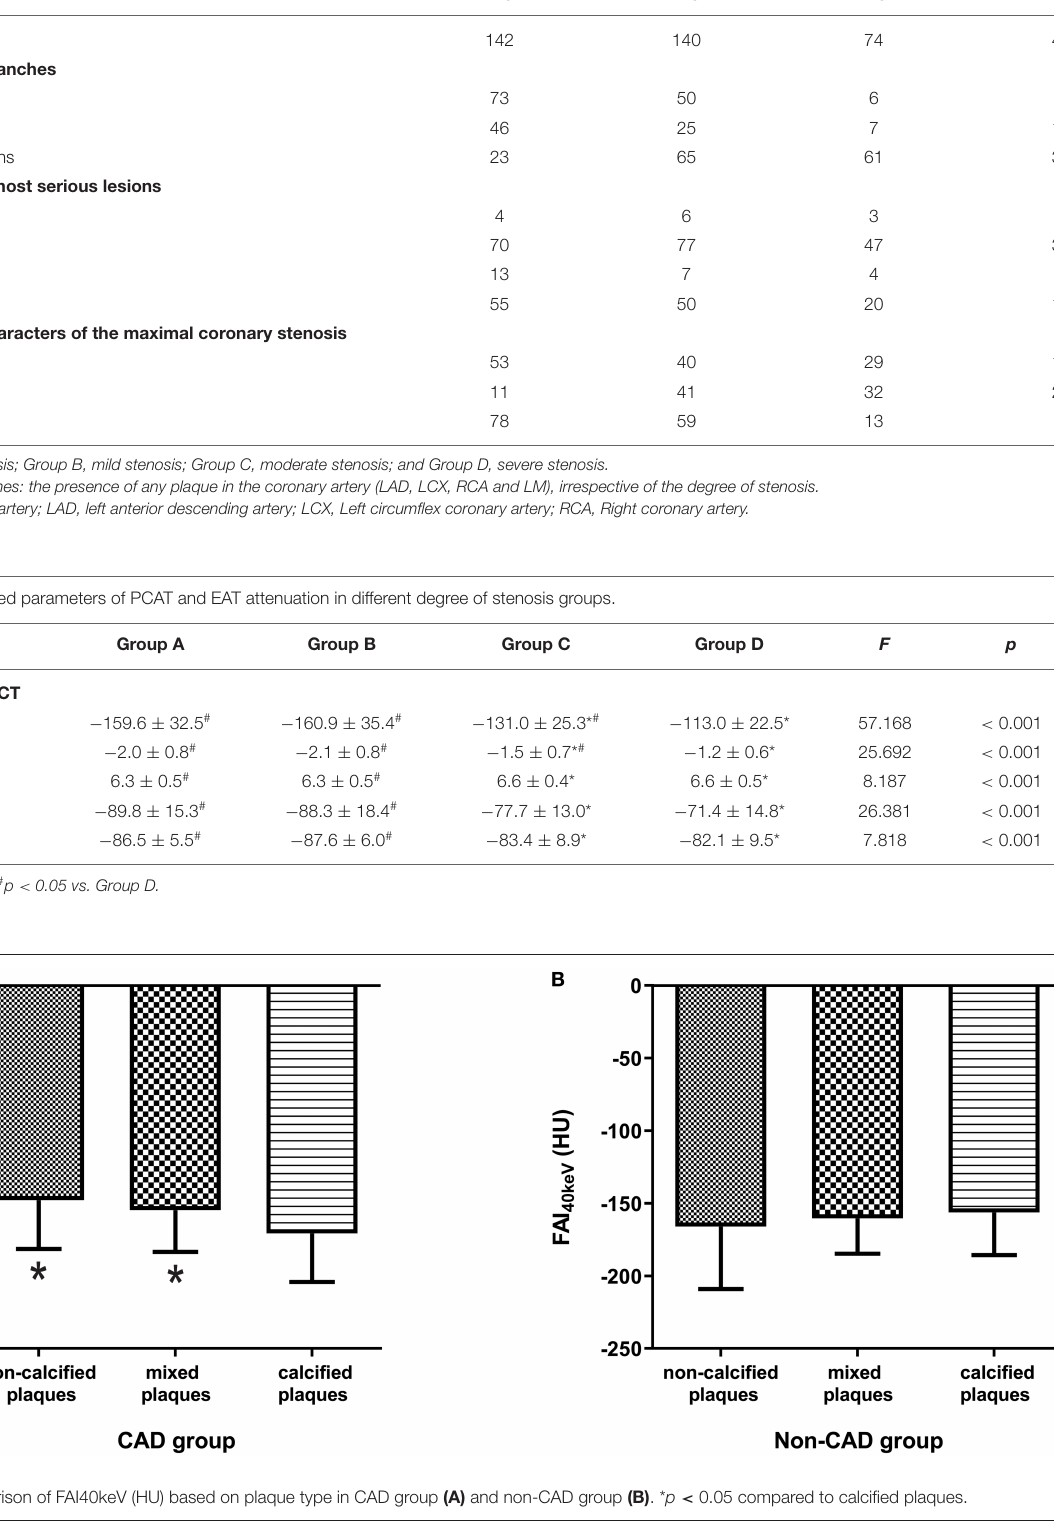
Frontiers in Cardiovascular Medicine |